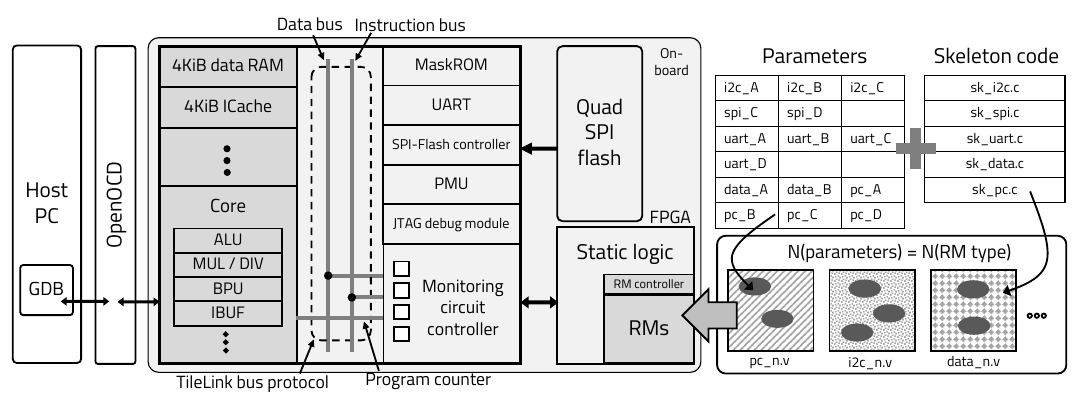
Figure 11. mFSP’s structure.